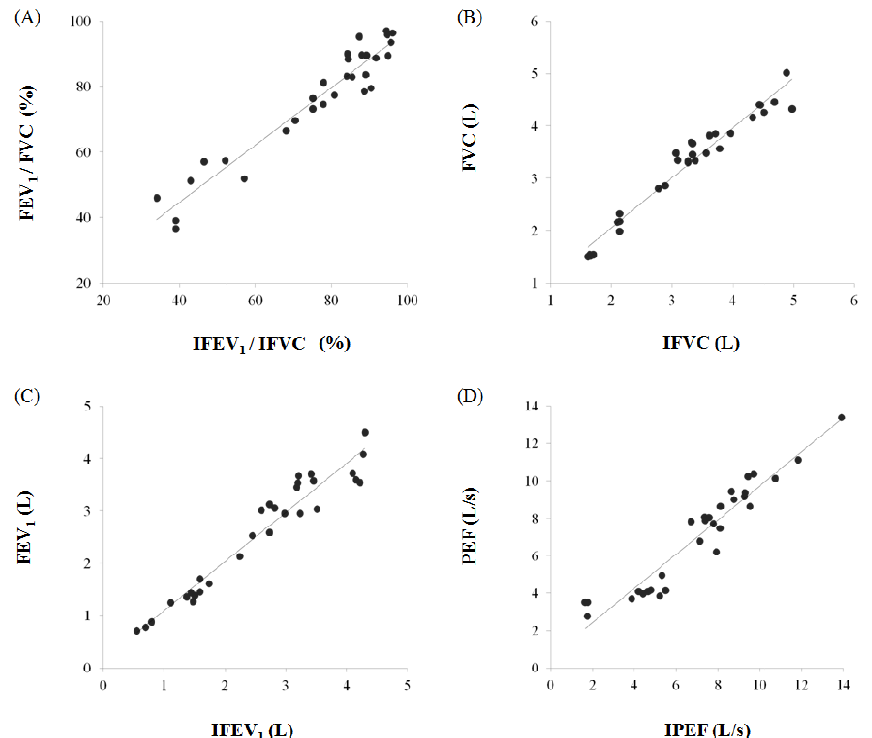
Figure 6. Correlation between PFT and IPFS indices: (